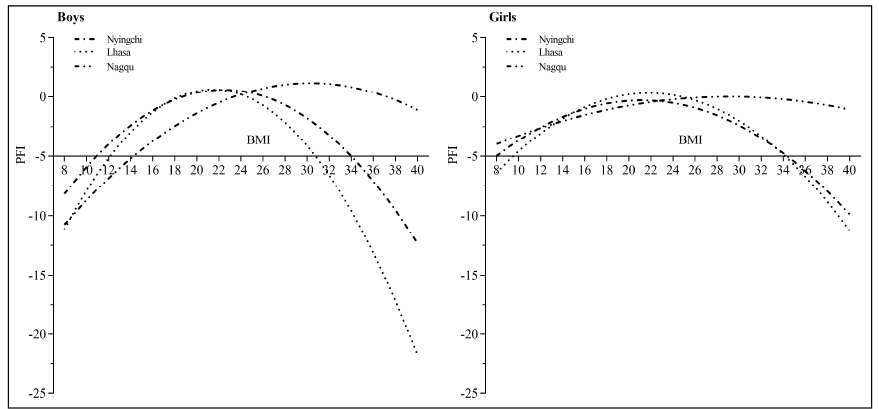
Figure 2. The relationship between body mass index and PFI of Tibetan children and adolescents of different genders at different altitudes.